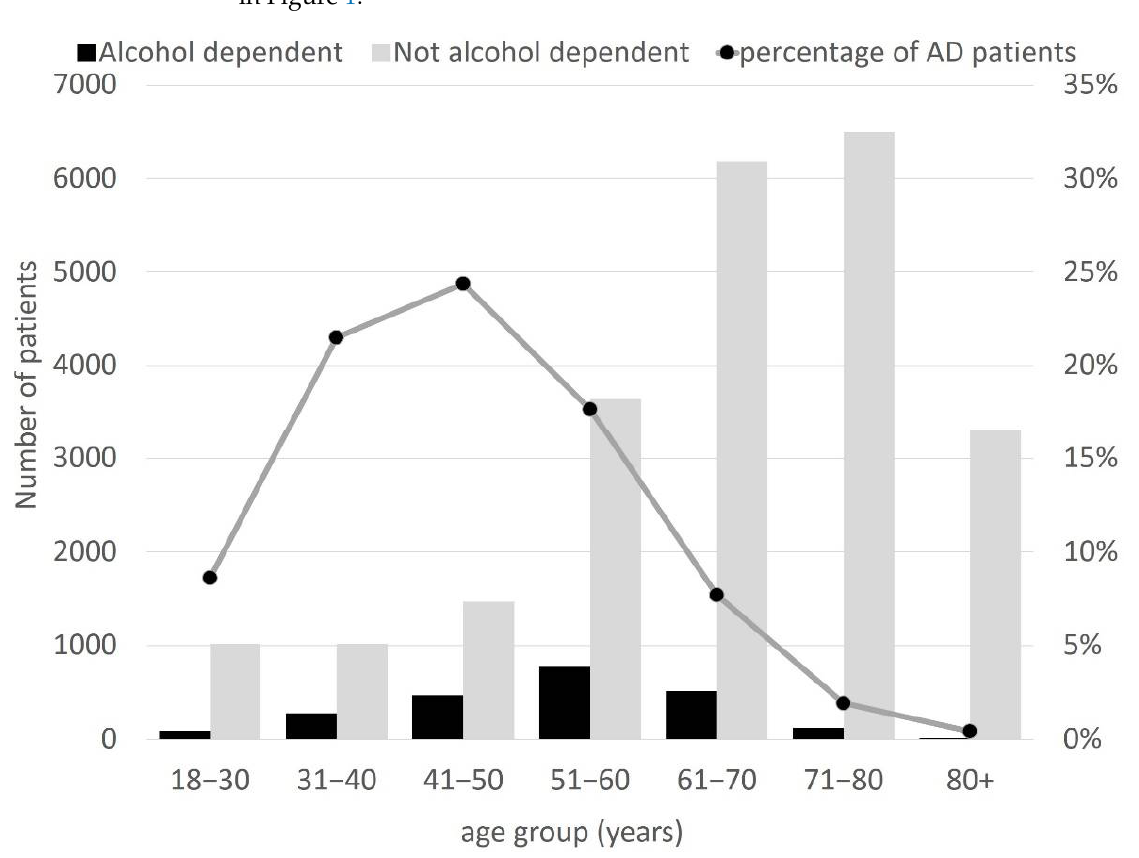
Figure 1. Overall number of patients and the percentage of patients in various age groups.